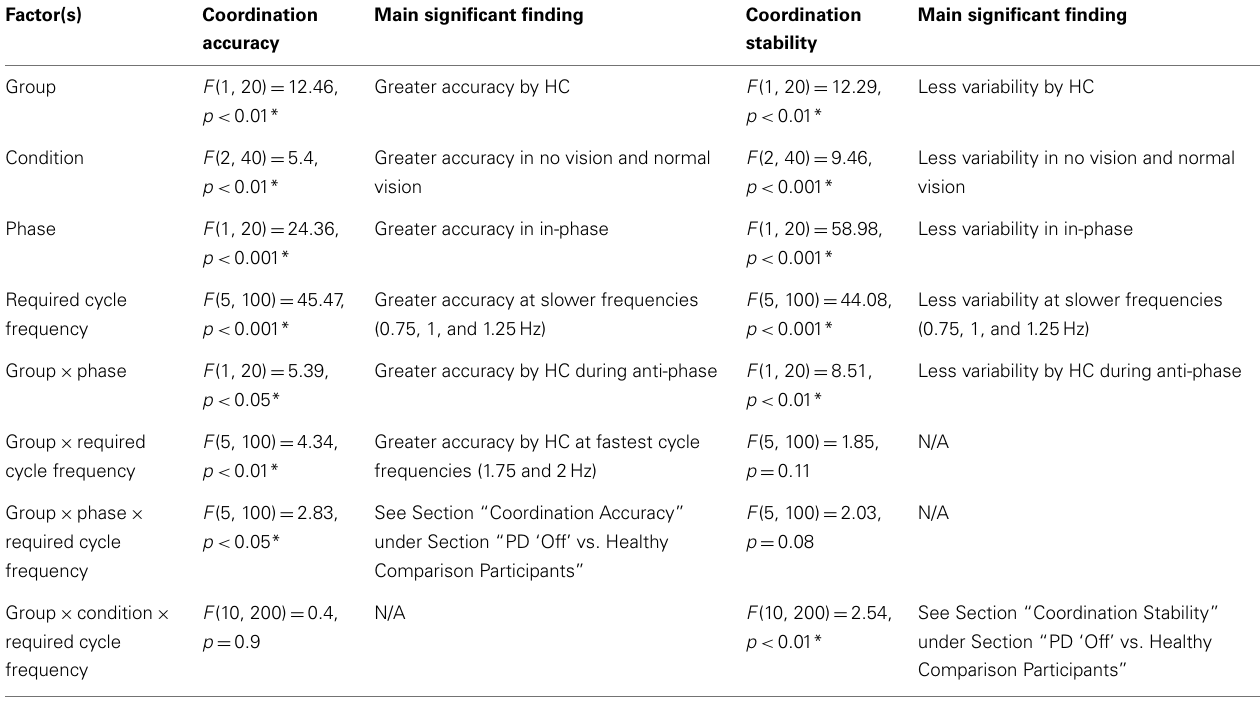
TableA1 | Statistical results fromANOVA analysis on planned comparison between PD “off” and healthy comparison (HC) participants and between PD “off” and PD “on” to evaluate the effects of basal ganglia dysfunction on coordination accuracy and stability.